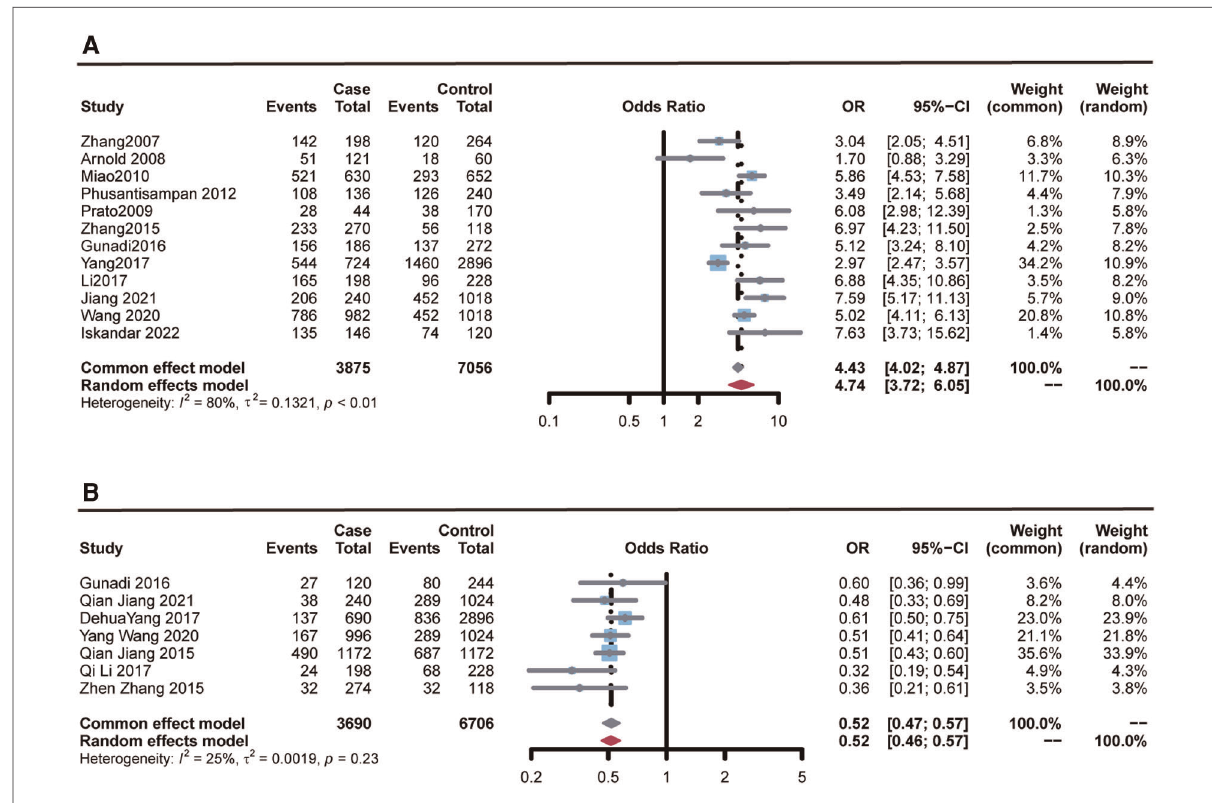
FIGURE 2 Forest plots of the association of rs2435357 and rs2506030 polymorphisms of the RET with susceptibility to HSCR. ( A ) rs2435357 (allele model); ( B ) rs2506030 (allele